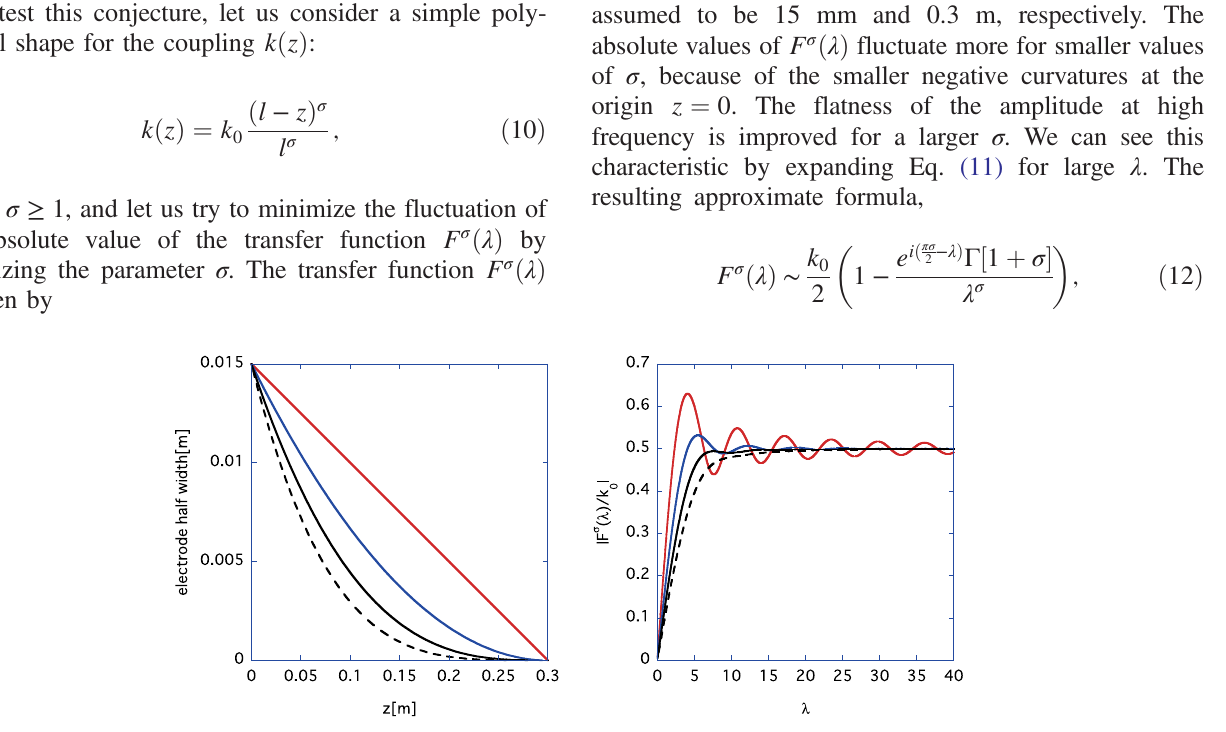
FIG. 4. The absolute values of transfer function j F σ ð λ Þ =k 0 j (right) and the shapes of electrode (left) for various values of σ . The red solid and the blue solid and the black solid and the black dashed lines depict the results of σ ¼ 1 ; 2 ; 3 and 4, respectively. The half width of the electrode at z ¼ 0 and the length l are assumed to be 15 mm and 0.3 m,